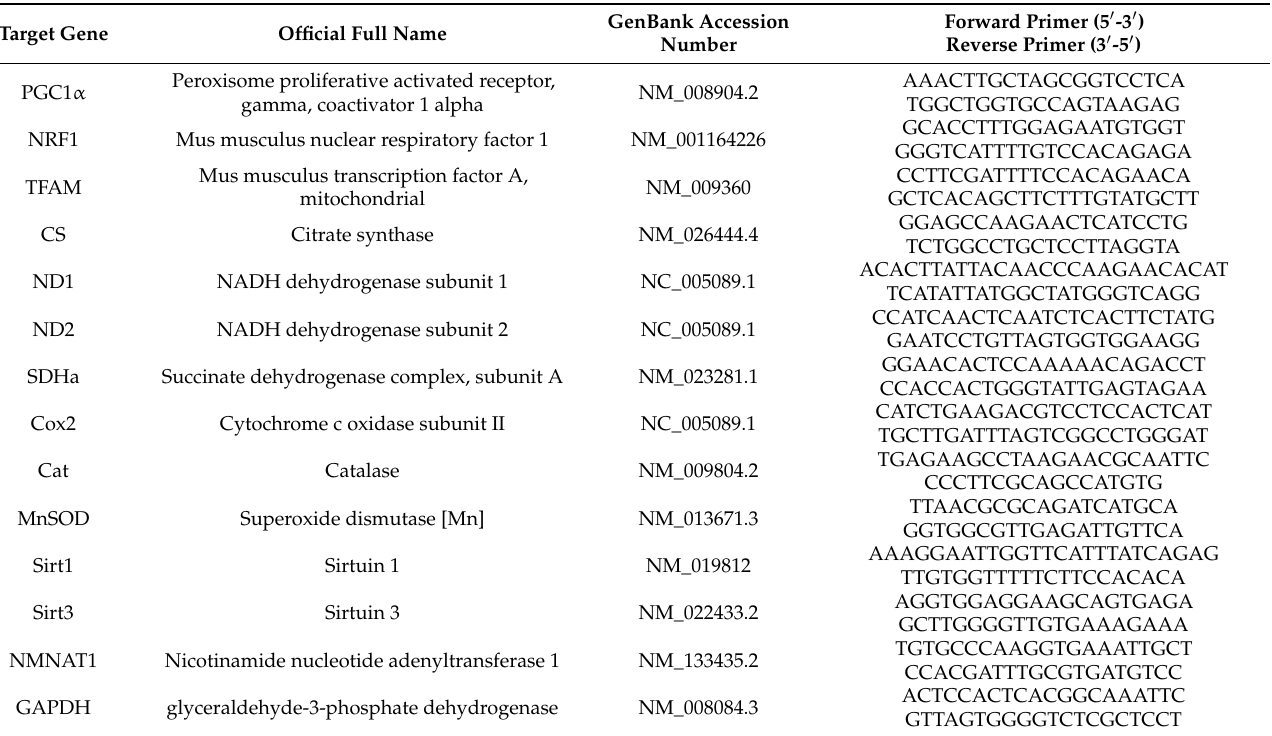
Table 2. Primer sequences used in real-time PCR